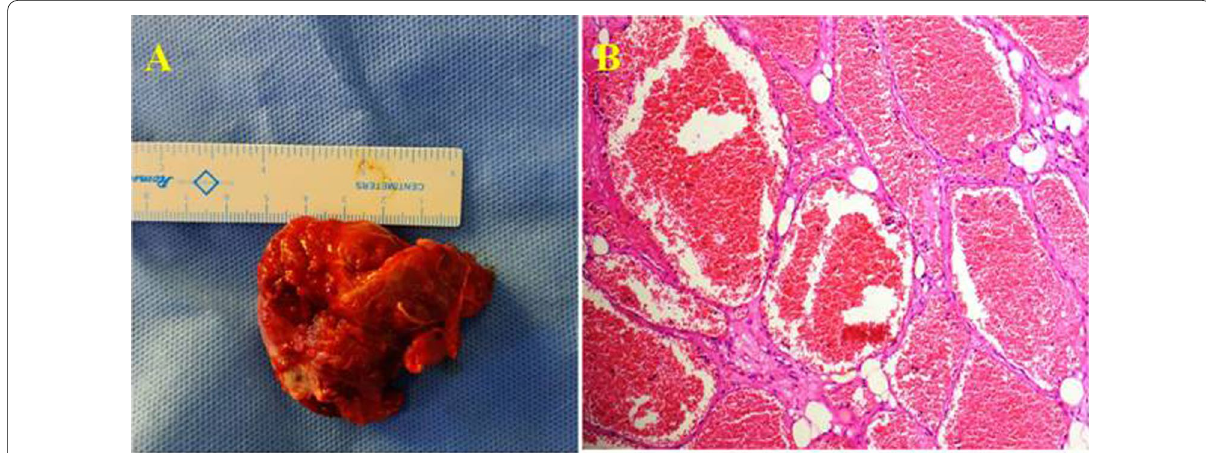
Fig. 4 Gross surgical specimen ( A ) shows a reddish vascular mass with glistening outer surface. Photomicrograph (Haematoxylin and Eosin, 200X) shows dilated and congested, blood-filled vascular channels ( B ) lined by bland endothelial cells suggestive of cavernous